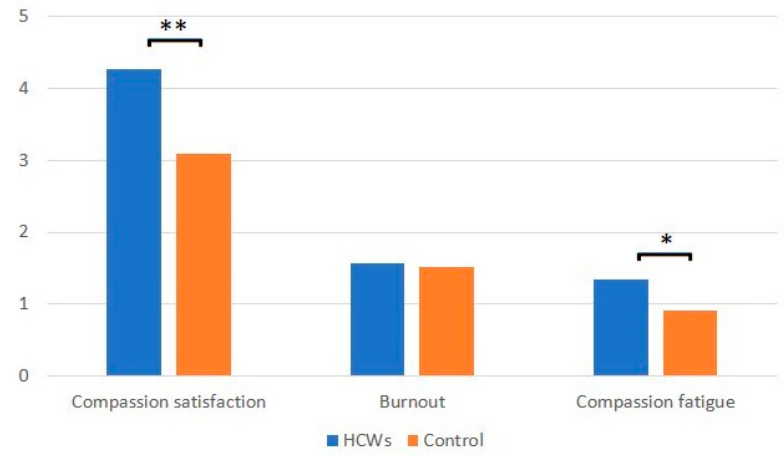
Figure 2. Results of ProQOL questionnaire (significance: * p < 0.1, ** p < 0.01).